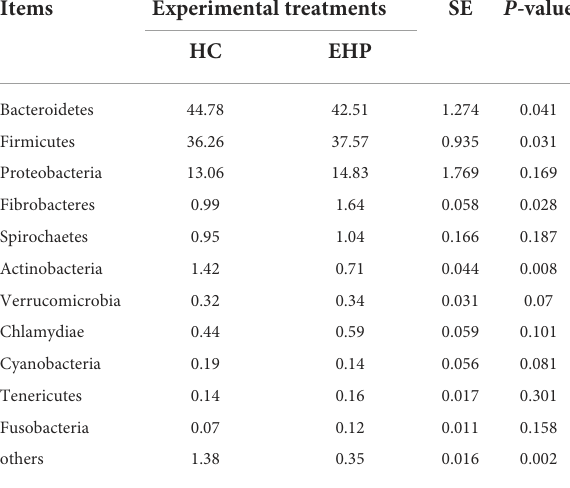
TABLE 5 Effects of small peptide supplement in high-concentrate diets on relative abundances of ruminal bacterial communities (%) (level of phyla) ( n , 6).